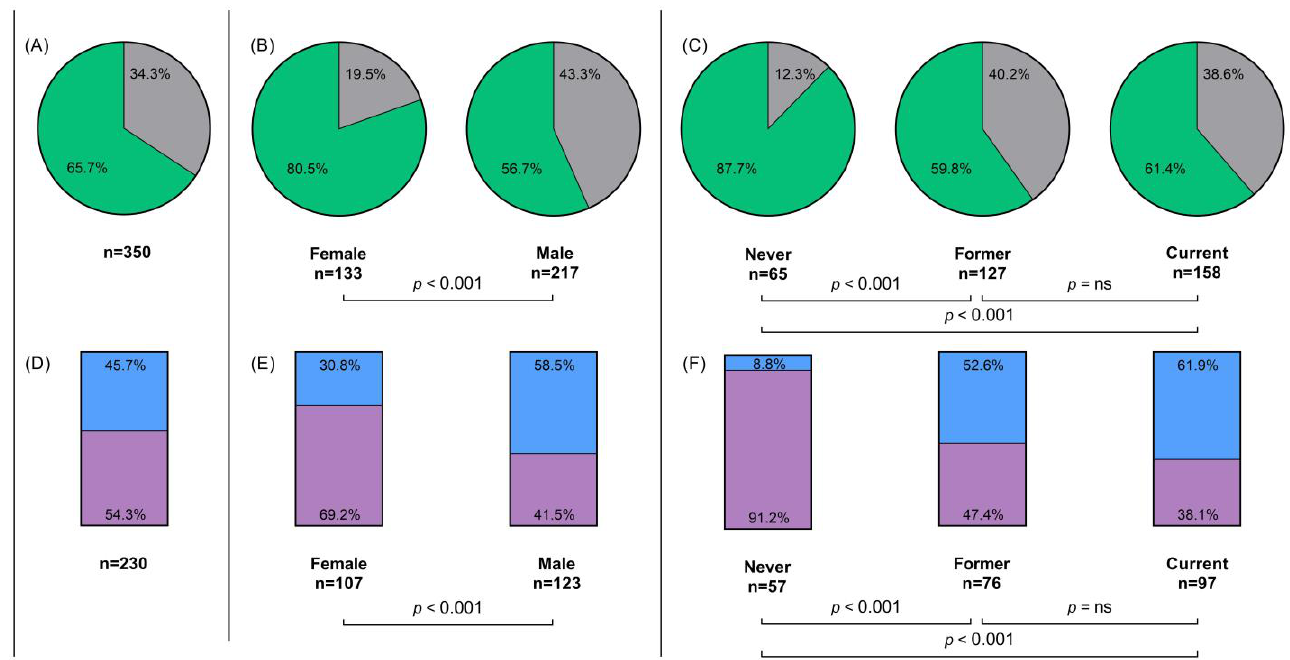
Figure 4. Actionable molecular alterations detected using NGS in our cohort. Percentage of patients with actionable genetic variants (green) in the global cohort ( A ), according to sex ( B ) and according to smoking status ( C ). Patient distribution according to the level of evidence of the detected variants in the global cohort ( D ), according to sex ( E ) and according to smoking status ( F ). Purple: patients who are candidates for treatment with approved drugs, blue: patients eligible for phase I – II clinical trials. ns: not statistically significant.